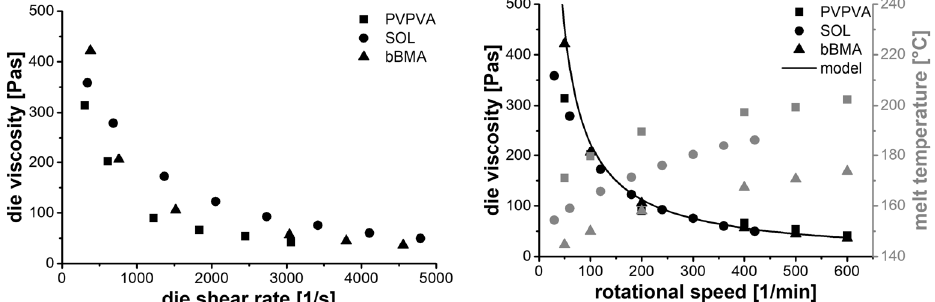
Figure 5. Results of autogenic extrusion experiments (Figure 4, C to D). Die viscosity as function of die shear rate ( left ), die viscosity (black) and melt temperature (grey) as function of screw speed ( right ).